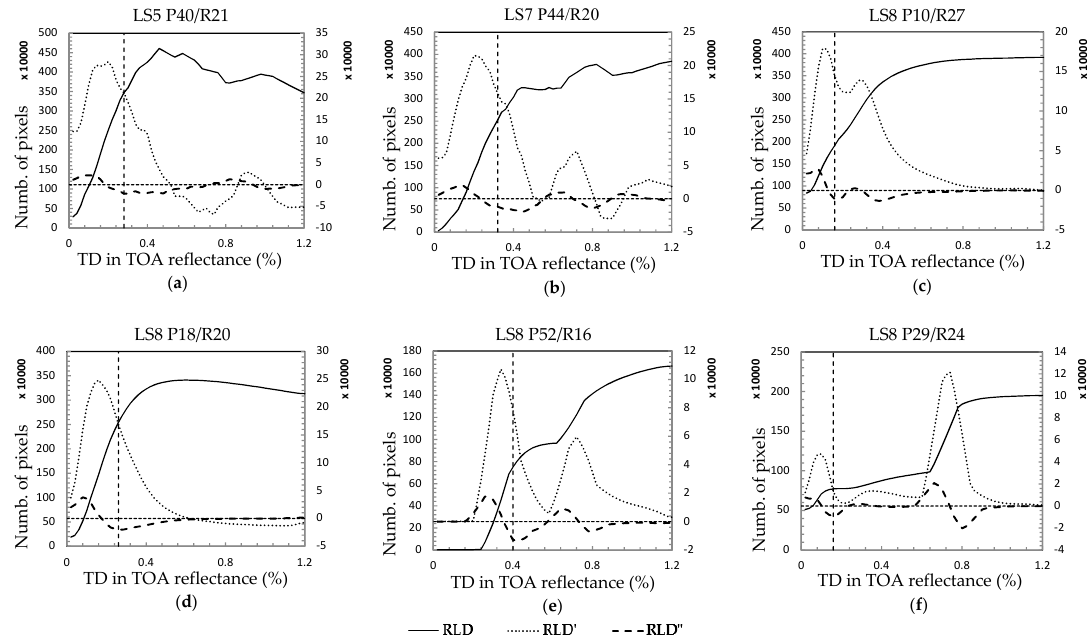
Figure 2. Representative regression line density (RLD) curves and corresponding derivatives of six Landsat scenes (described in Section 2.1). The solid, dotted and dashed curves are original RLD, 1st-order and 2nd-order derivative, respectively. The vertical dashed lines indicate the optimal trimming distances automatically detected by AutoHOT. The primary vertical axis is for the original RLD curves, while the secondary vertical axis is for 1st-order and 2nd-order derivative curves.